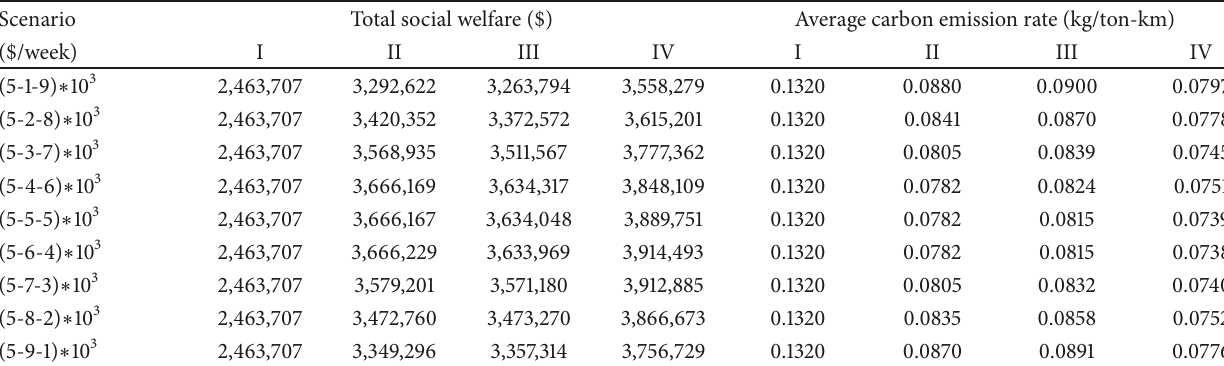
Table 5: Network performance of different mode strategies under different budget